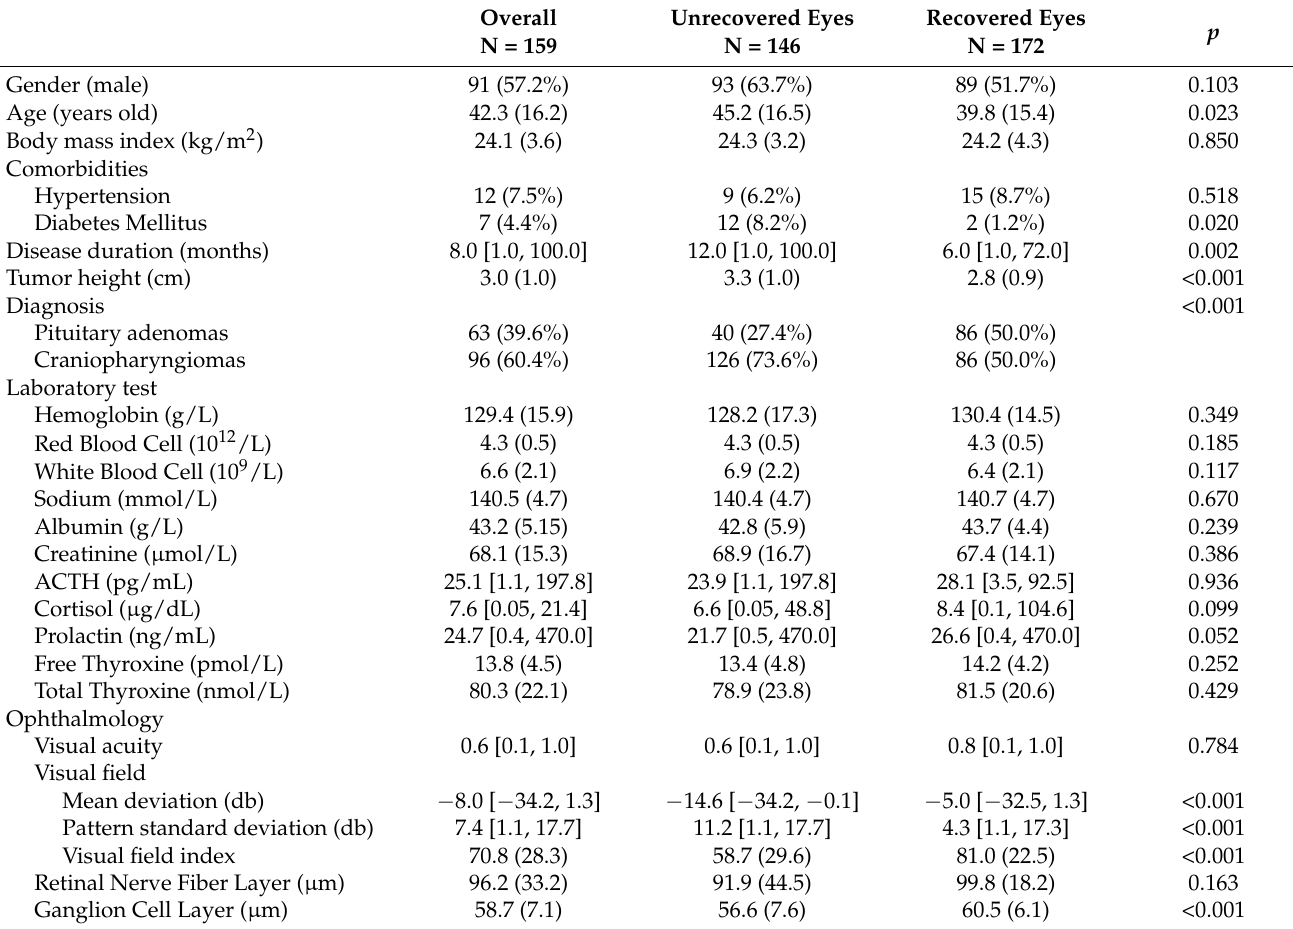
Table 1. Overall characteristics of the